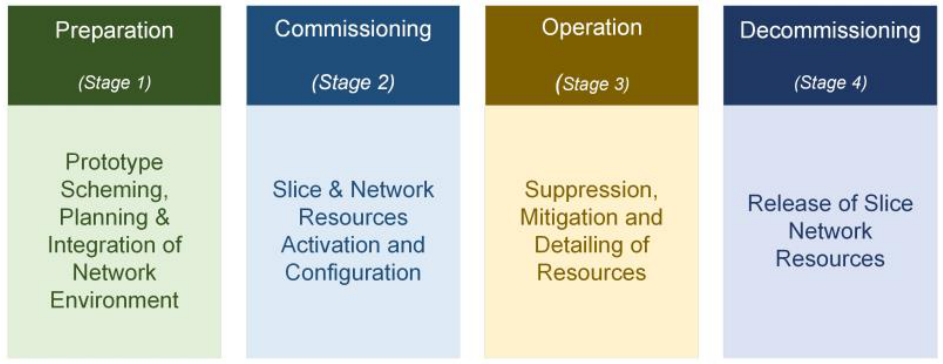
Figure 4. Organization of NS